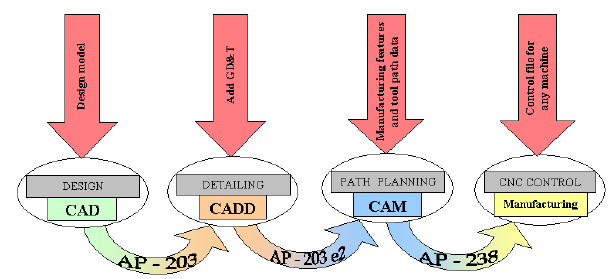
Figure 3. Data flow using STEP